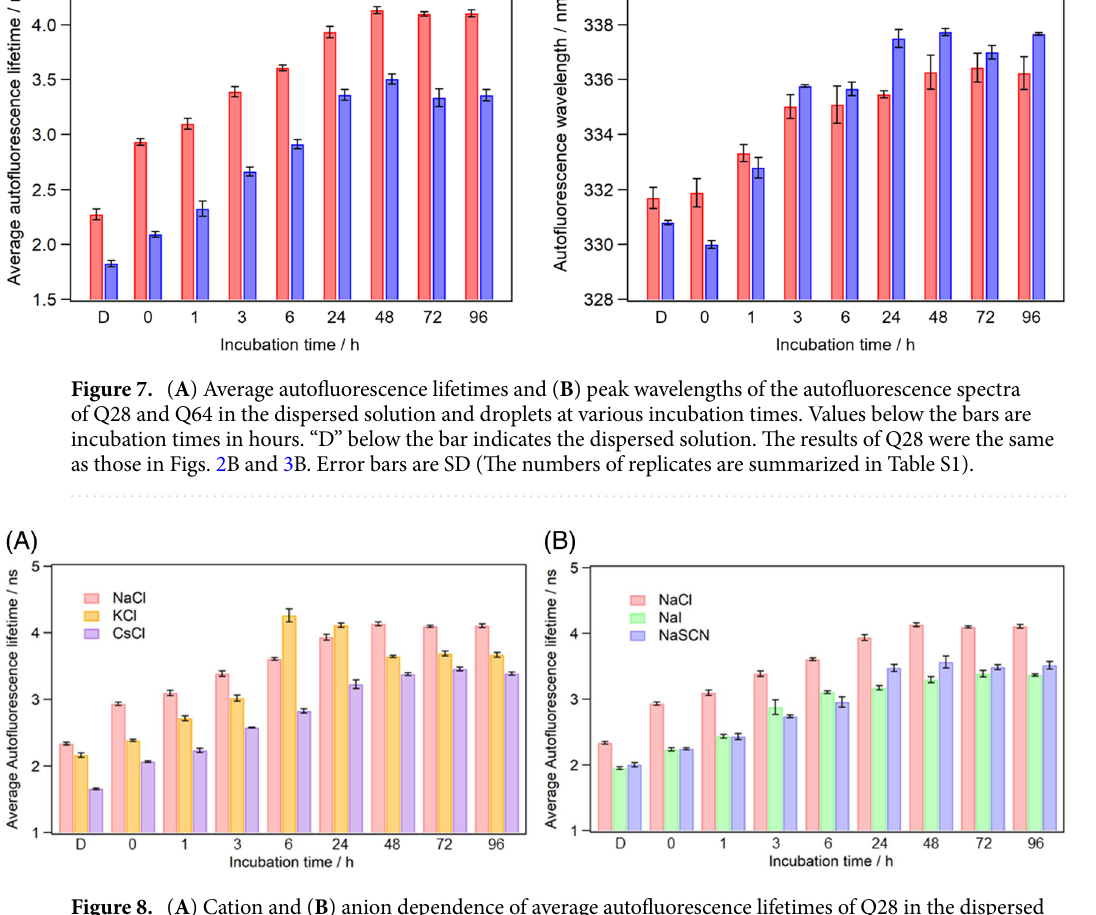
Figure 8. ( A ) Cation and ( B ) anion dependence of average autofluorescence lifetimes of Q28 in the dispersed solution and the droplets at various incubation time. Values below the bars are the incubation times in hours. “D” below the bar indicates the dispersed solution. Error bars are SD (The numbers of replicates are summarized in Table